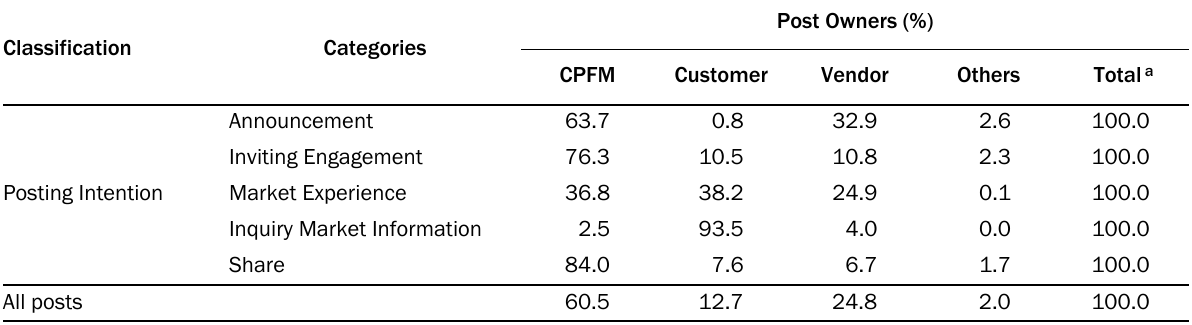
Table 1. Distribution of Posts ( N =6,369) by Post Owner, Posting Intentions and Media Type